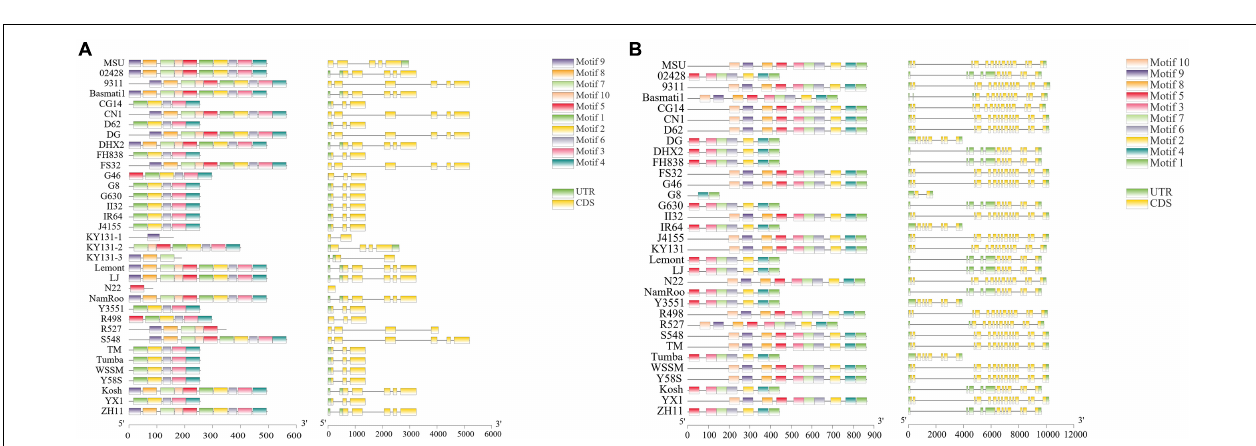
FIGURE 4 | SVs affecting the gene structure of TPS9 (A) and TPS29 (B) in 33 rice